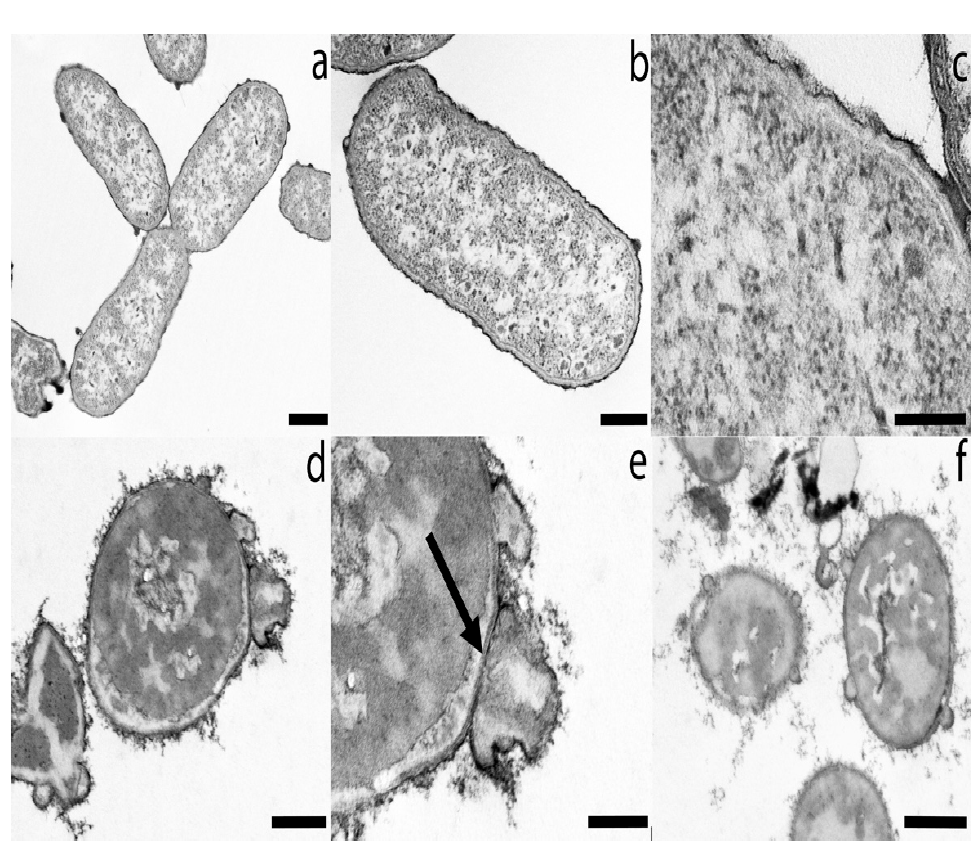
Figure 2. The figure shows TEM micrographs of untreated K. pneumoniae samples ( a – c ) and K. pneumoniae treated with O. glandulosum ( d , e ) and L. dentata ( f ) essential oil at the mean MIC value. ( a ) Three typical rod-shaped cells. Those lined up are still dividing. ( b ) A bacterial cell taken at higher magnification shows the grainy protoplast delimited by a smooth external cell wall. ( c ) Detail of a bacterial cell shows the grainy protoplast and the multi-layered surface, taken at higher magnification. ( d ) A O. glandulosum essential oil-treated bacterial cell with a globular-shape appearance. The protoplast, not grainy, is electron dense in large areas. The surface developed large bulges and an external hairy material. ( e ) Details of the altered cell taken at higher magnification. The arrow shows the continuity of the inner membrane and the cell wall. ( f ) Bacterial cells treated with L. dentata essential oil. The protoplast, with no grainy appearance, appears moderately dense in large areas. Scale bars: 500 nm ( a , f ); 300 nm ( b , d ); 200 nm ( c , e